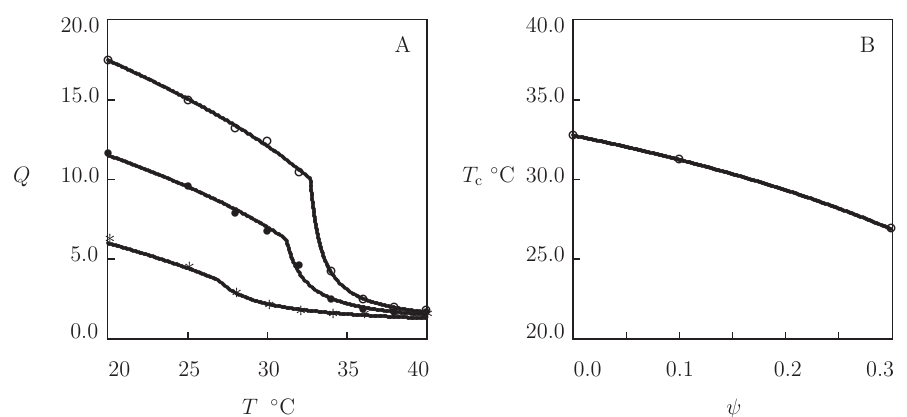
Figure 2. ( A ) Degree of swelling Q versus temperature T . Symbols: experimental data [47] on P(NIPAm-HEMA) gels with various molar fractions of HEMA monomers ψ = 0 ( ψ = 0.3 ( ). Solid lines: results of simulation. ( B ) Volume phase transition temperature T c versus ∗ molar fraction of HEMA monomers ψ . Circles: experimental data. Solid line: results of